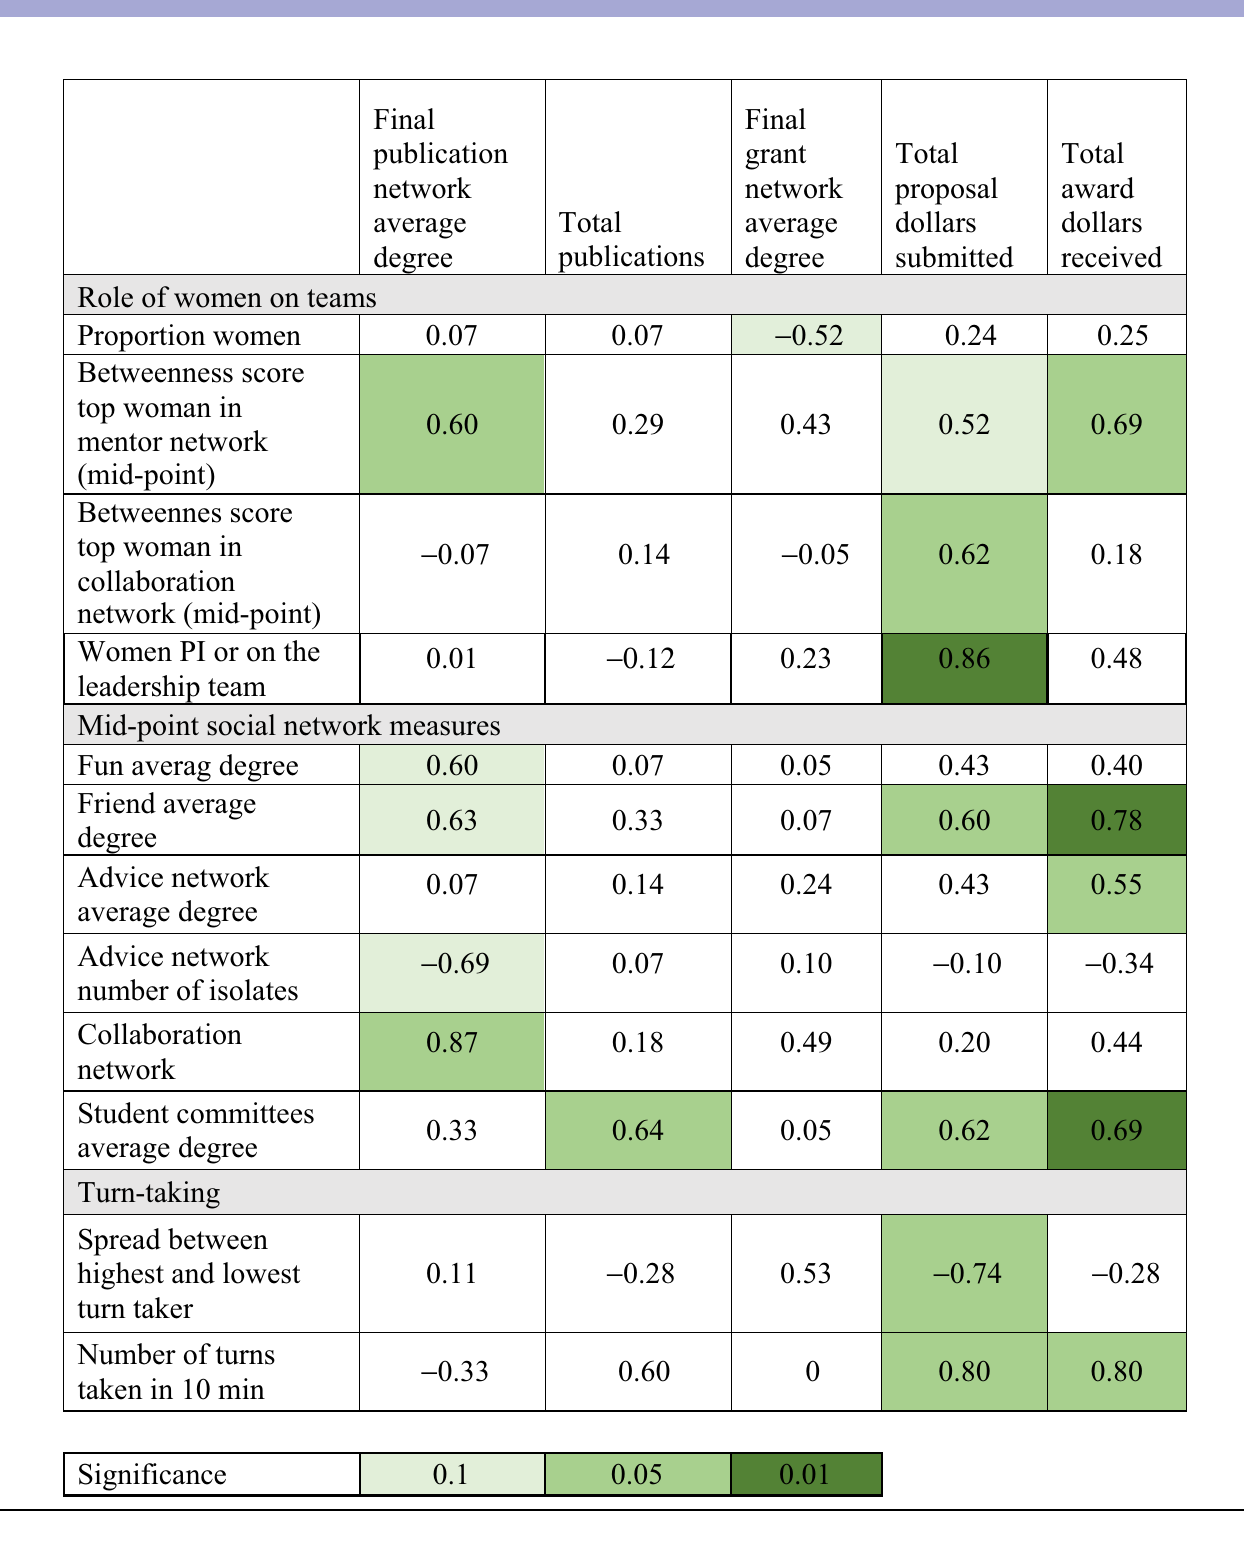
Mid-point social network measures . Knowledge creation has traditionally been framed in terms of individual creativity, but recent literature has placed more emphasis on social dynamics. A team with a high average degree hangs out with more team members for fun and/or considers more team members friends